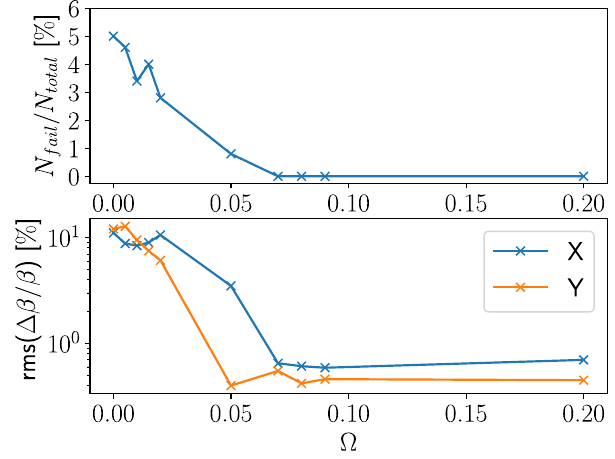
modulation that converges to the wrong solution (top) and statistical uncertainty of the measurements (bottom).